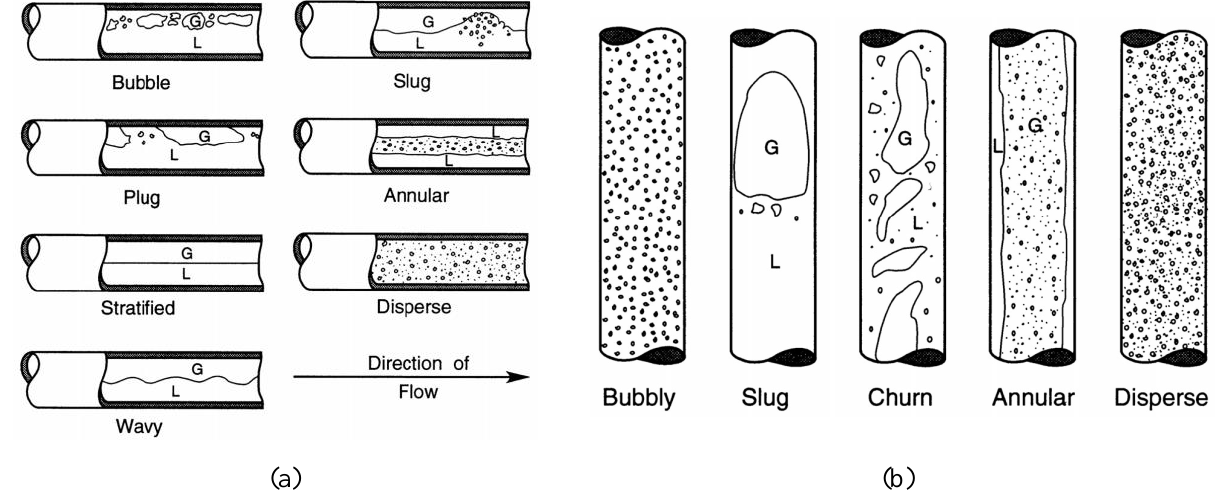
Figure 4. Schematic representation of the ( a ) horizontal and ( b ) vertical gas – liquid flow patterns defined by Weisman [28].